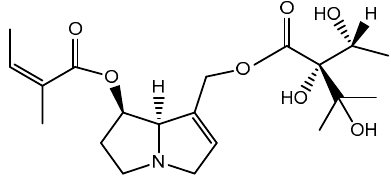
Figure 5. Chemical structure of echimidine, a diester of monocarboxylic acid.